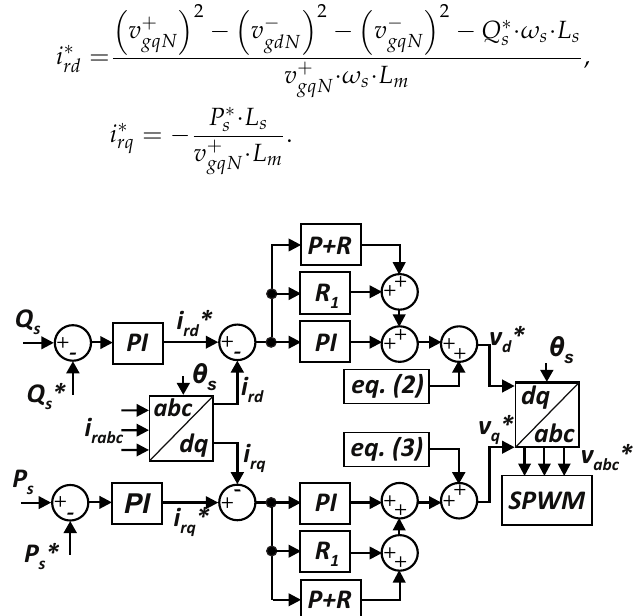
Figure 4. RSC control strategy. θ S is the slip angle or rotor electrical